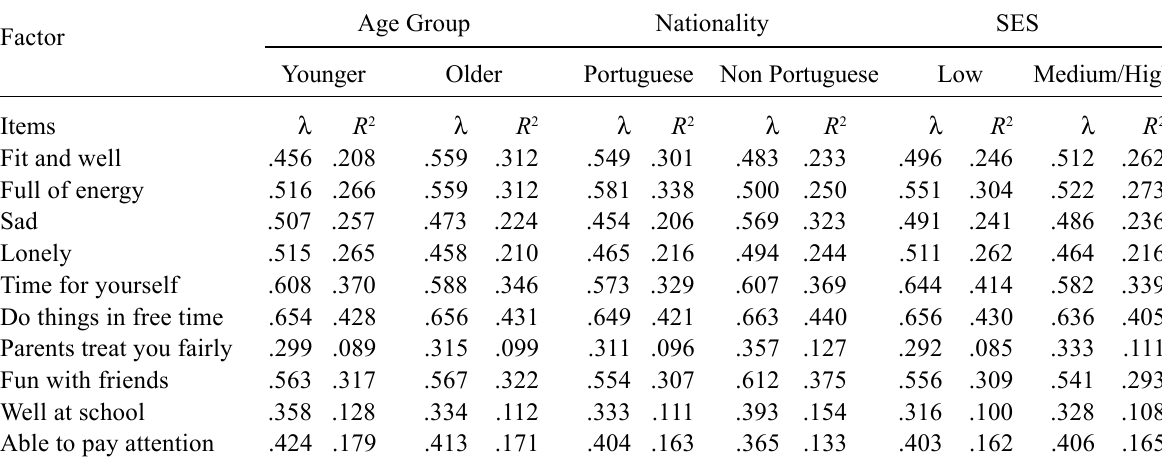
Invariance Testing: Factor Loadings ( λ ) and Explained Variance (R 2 ) for all 10 KIDCREEN